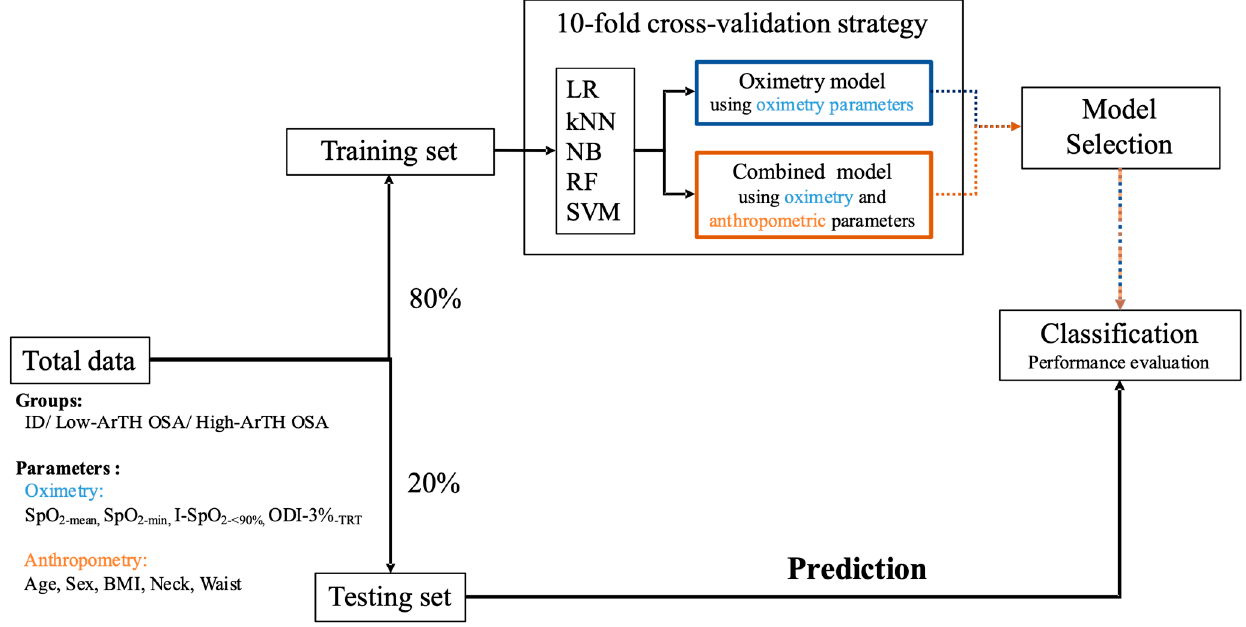
Figure 3. Model establishment process. All data were separated at a ratio of 80:20 to act as the training–validation dataset and testing dataset. The k-fold cross-validation technique (k = 10) was employed in the training–validation stage to separately develop two types of models through five machine learning approaches. Subsequently, the models with the highest accuracy in oximetry typing and combined parameter typing were respectively used to predict the testing dataset for evaluating the overall accuracy and input feature importance. Abbreviations: ID: insomnia disorder; ArTH: respiratory arousal threshold; OSA: obstructive sleep apnea; LR: logistic regression; kNN: k-nearest neighbors; NB: naive Bayes; RF: random forest; SVM: support vector machine; SpO 2-mean : mean level of peripheral arterial oxygen saturation measured using pulse oximetry; SpO 2-min : minimum level of peripheral arterial oxygen saturation measured using pulse oximetry; I-SpO 2-<90% : index for the ratio of the amount of time during which the peripheral arterial oxygen saturation measured using pulse oximetry is lower than 90% to the sleep period time; ODI-3% -TRT : total number of oxygen desaturation events (>3%) divided by the total recording time; BMI: body mass